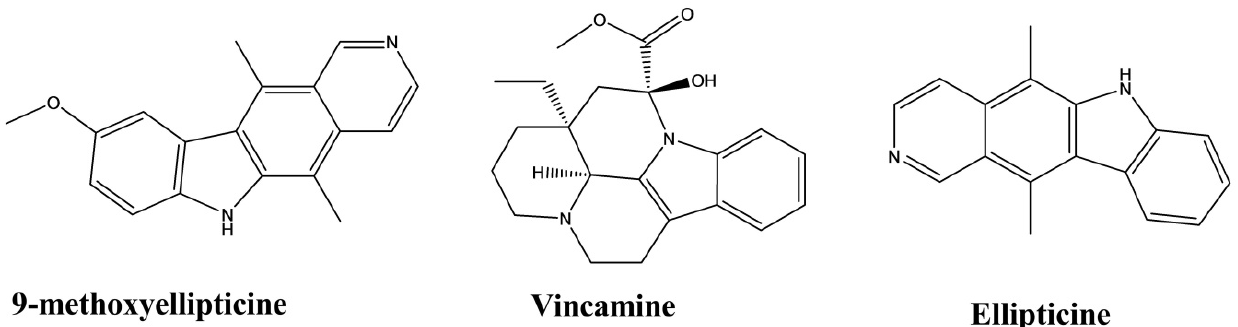
Figure 17. Lipid-lowering activity of indole alkaloids.